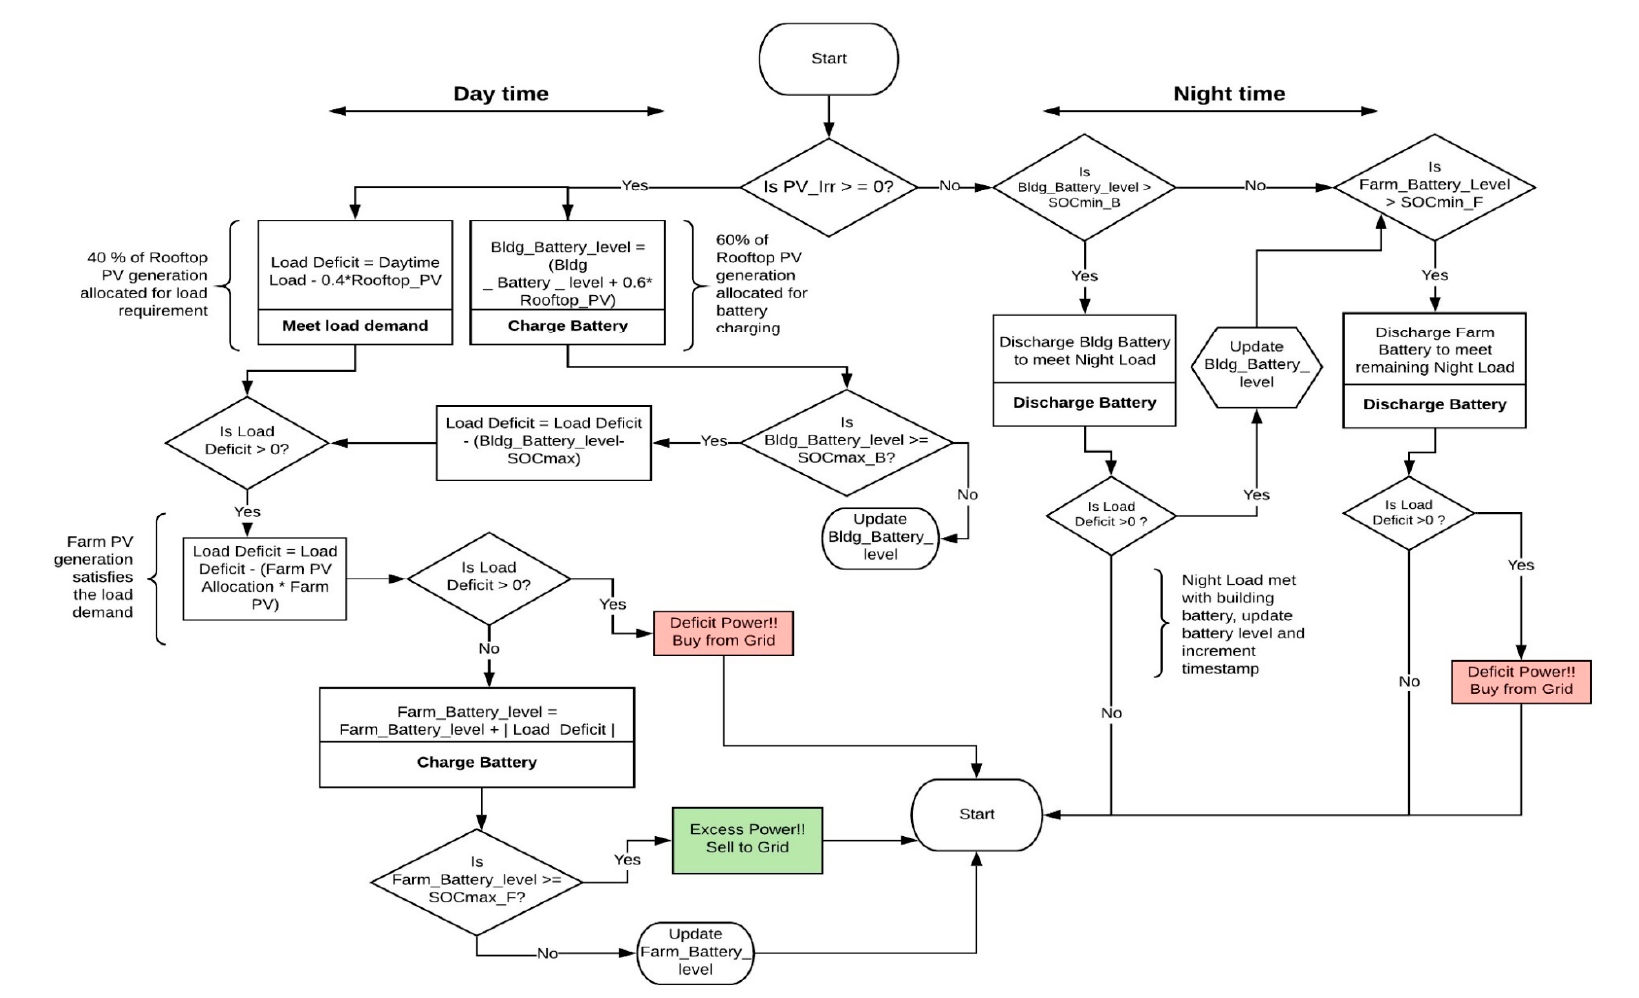
Figure 10. Flowchart of the MATLAB code.